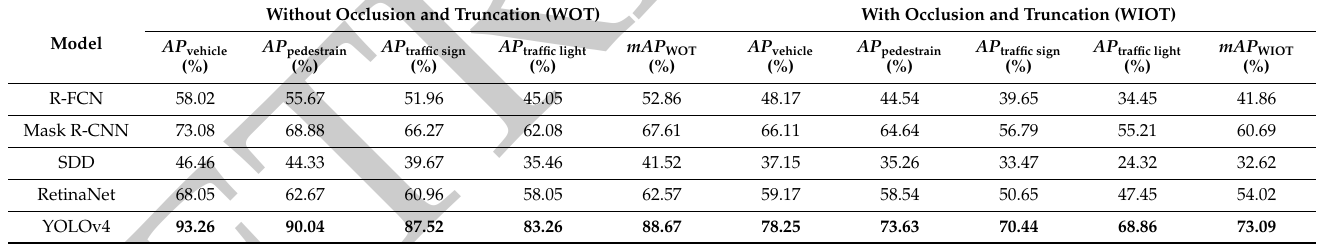
Table 5. Detection Accuracy of Object Detect Models on BDD100K dataset.